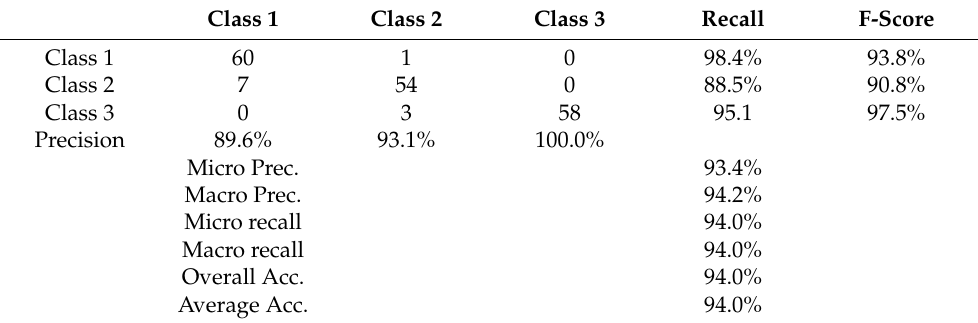
Table 8. Confusion matrix assessing CNN trained with “no or fewer shadows” images, tested with “with